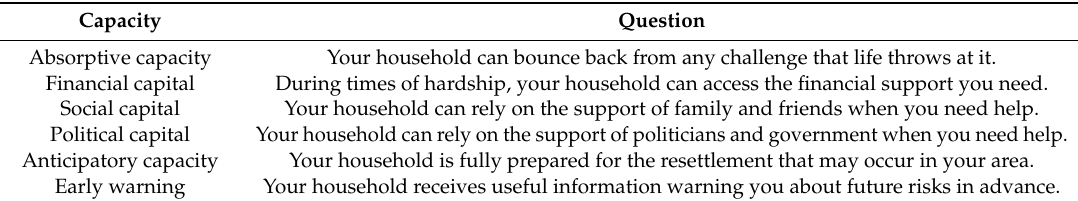
Table 3. Resilience-related capacity questions used in the subjective self-evaluated resilience score